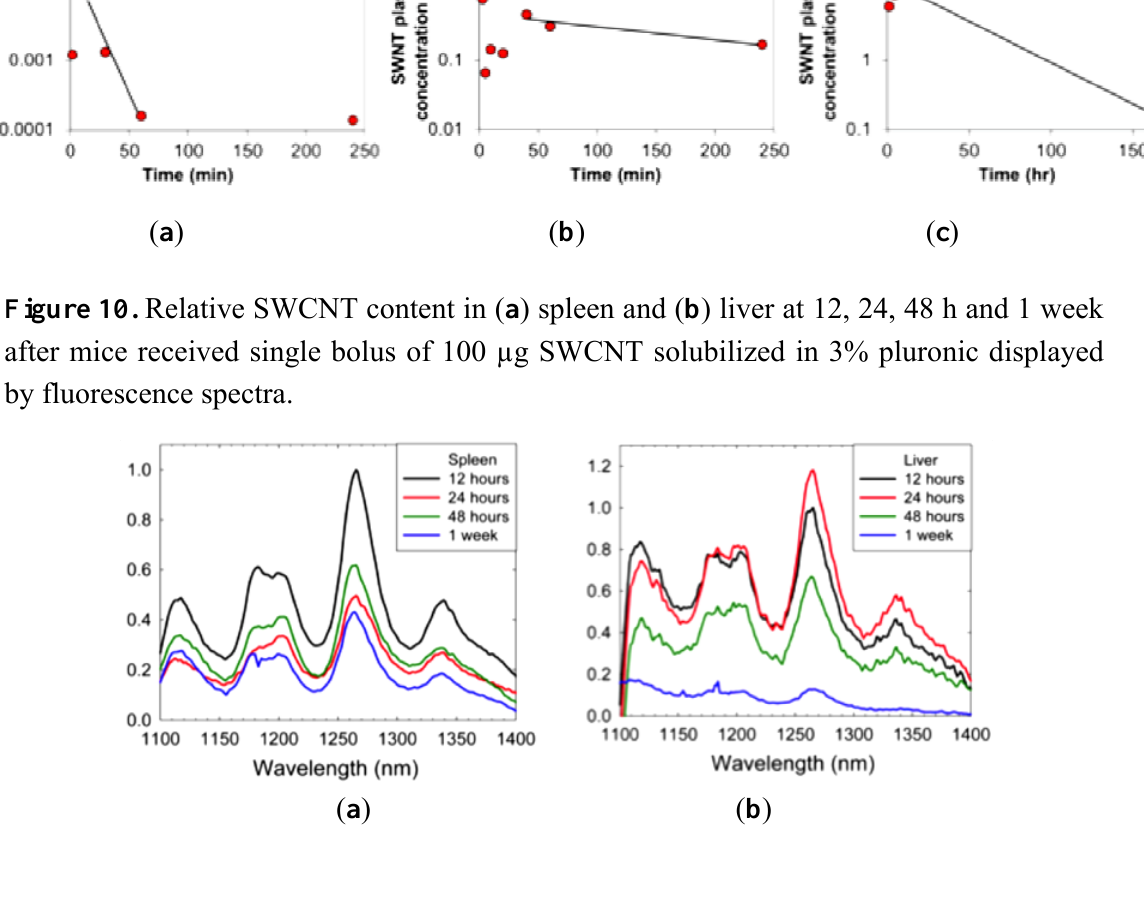
Figure 9. SWCNT complexed with siRNA and with excipients to modify the circulation time. ( a ) siRNA/ l -PEG (400 µM)/SWCNT, t